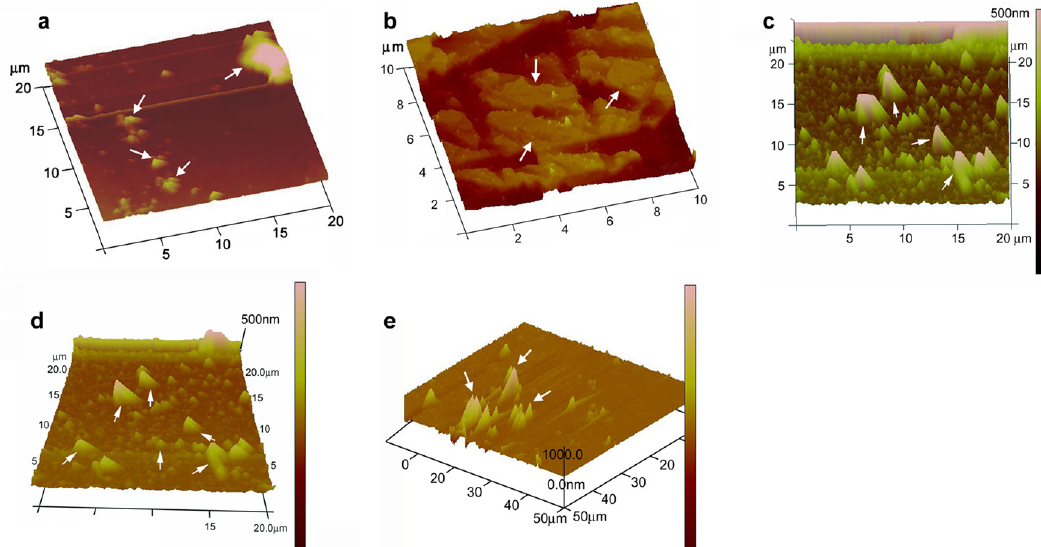
Figure 3. AFM images of KG-metal complexes indicating metal-capped structures